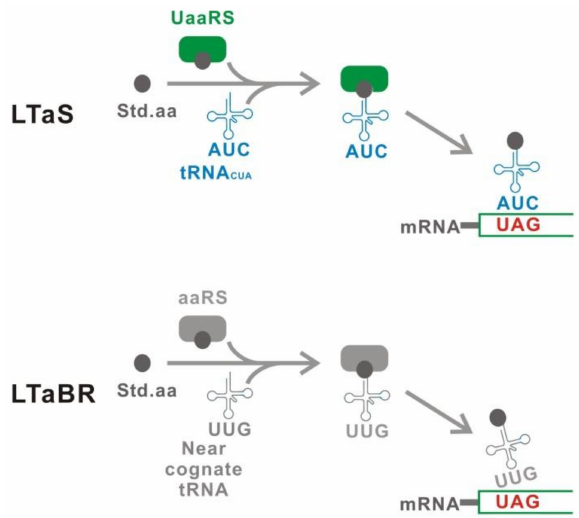
Figure 4. Two components of the leakage translation. The leakage translation attributed to the switch (LTaS) is mainly caused by misacylation of tRNA CUA with a natural amino acid, which is a poor substrate of UaaRS. The leakage translation attributed to the basal read-through (LTaBR) is derived from read-through caused by near-cognate tRNAs. The LTaBR is independent of the performance of the Uaa translational